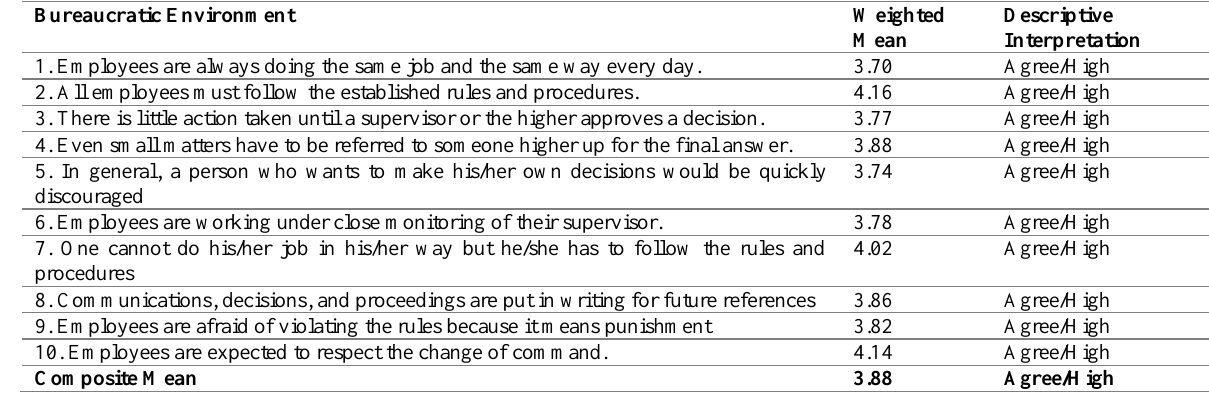
Table 4: Bureaucratic Environment